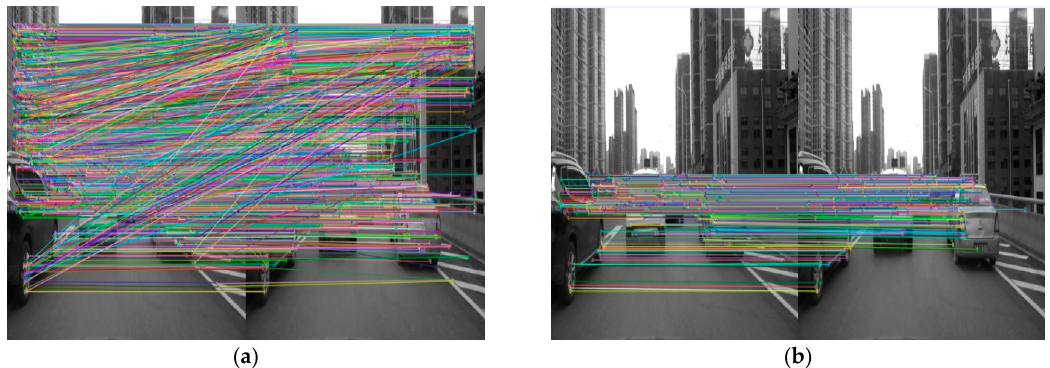
Figure 3. Extraction of feature points of front vehicle based on analysis of motion vectors. ( a ) Matching of feature points in entire image; ( b ) Matching of feature points of front vehicle.